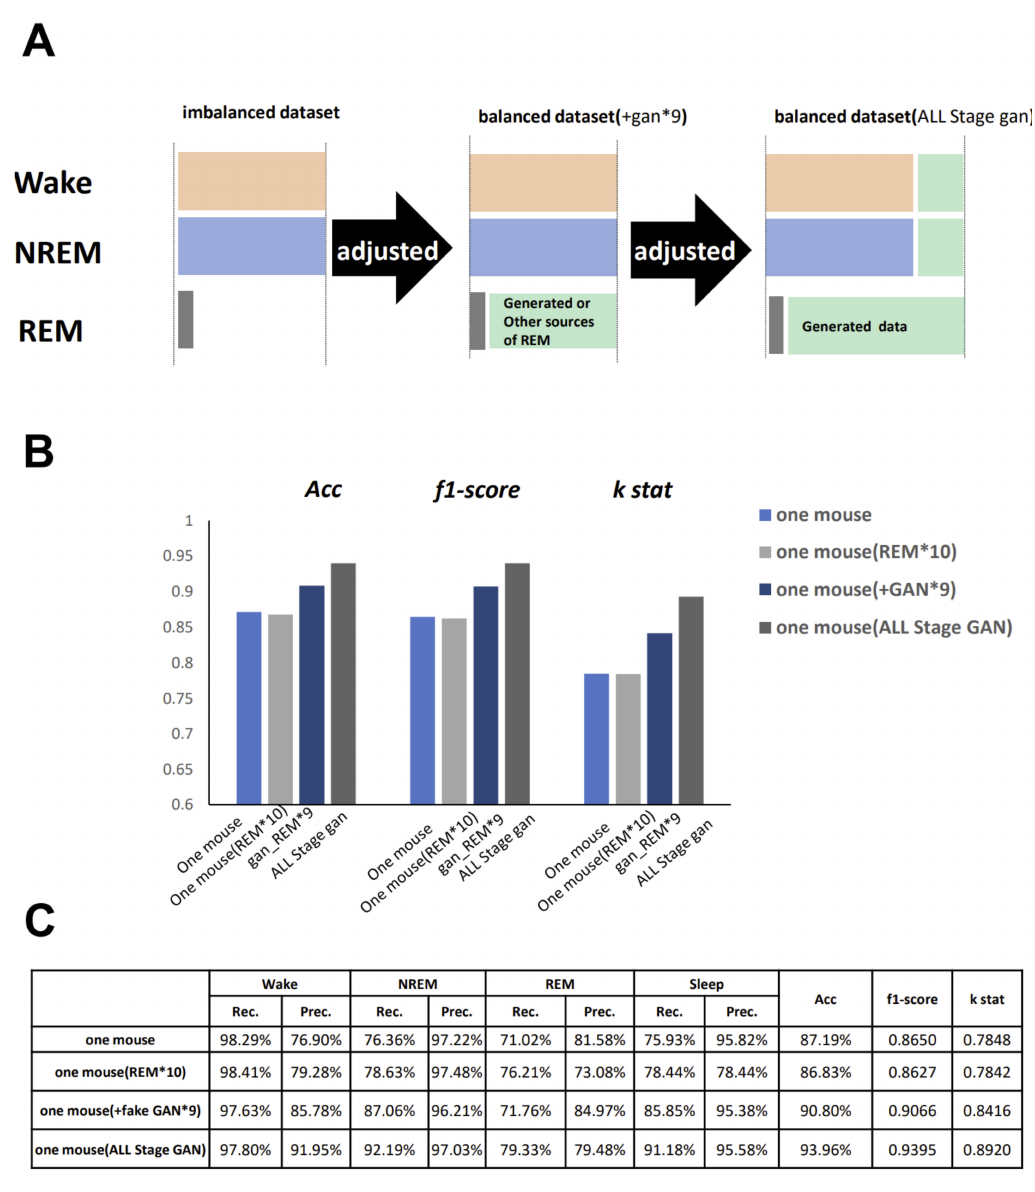
Figure 8. Expansion of all three-stage images by GAN. ( A ) Schematic representation of the protocol to create fake images for all three stages. ( B ) Comparison bar graph of three parameters between different conditions. ( C ) Data table. Left side show the specific dataset we used for training. ‘REM*10’ means that the data of REM is copied ten times than before. ‘gan_REM*9’ and ‘ALL_stage gan’ is described in